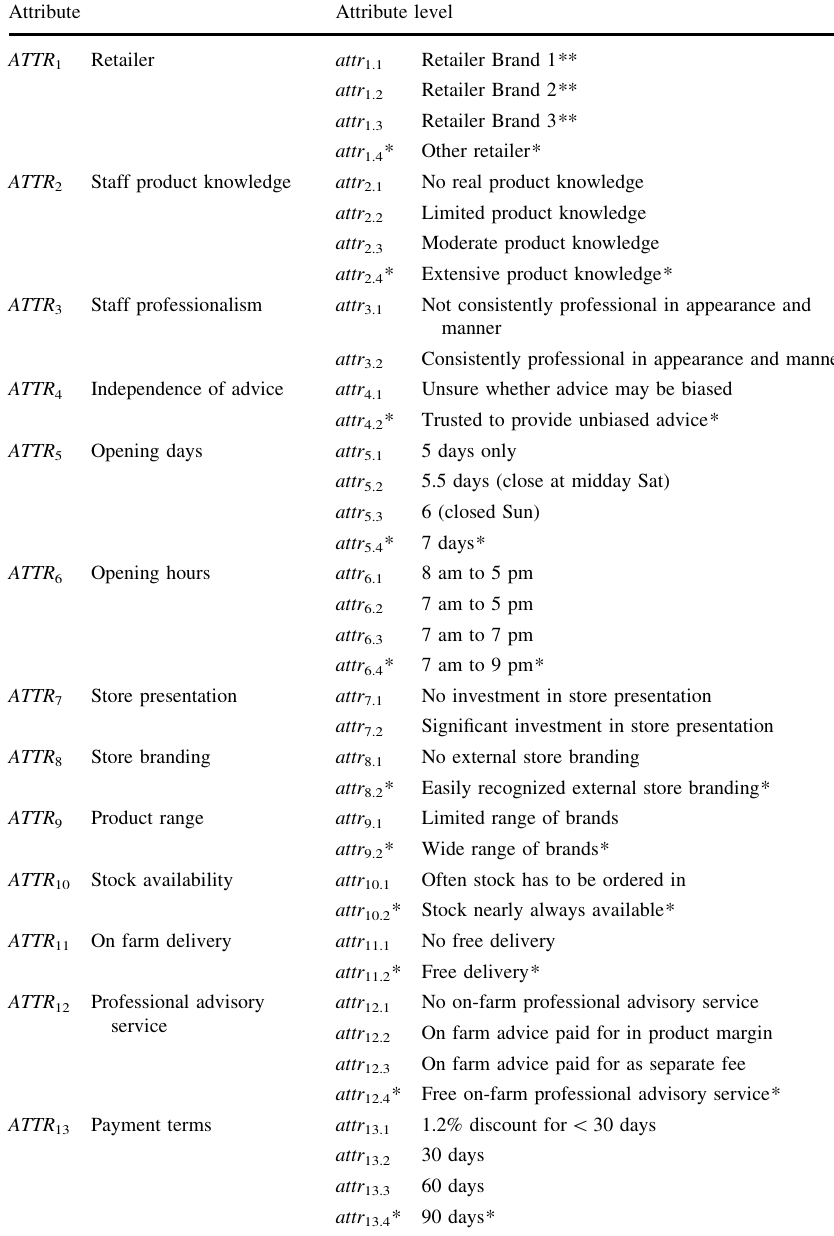
Table 4 Discrete choice